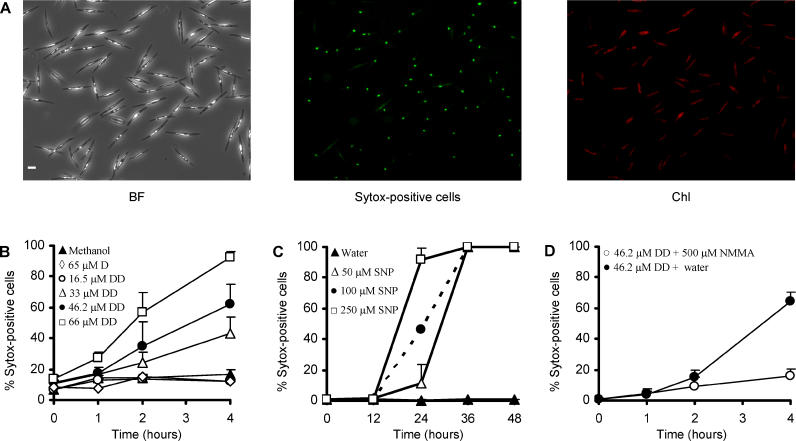
DD-Dependent NO Production Induces Cell Death(A) Micrographs of P. tricornutum cells treated with DD (66 μM [10 μg/ml]) for 4 h, which resulted in 90% cell death (assayed by Sytox Green fluorescence). Chlorophyll autofluorescence (shown in red) was significantly reduced in Sytox-positive cells, giving a further indication of cell death.(B–D) Quantification of cell death kinetics induced by DD or (2E)-decenal (B), SNP (C), and NMMA added prior to DD application (D). Data in (B–D) are means plus standard deviation from four experiments. Representative data from four experiments are shown in (A). Experiments shown in (B–D) were performed by flow cytometry. Abbreviations are as in Figure 1. Scale bar represents 5 μm.